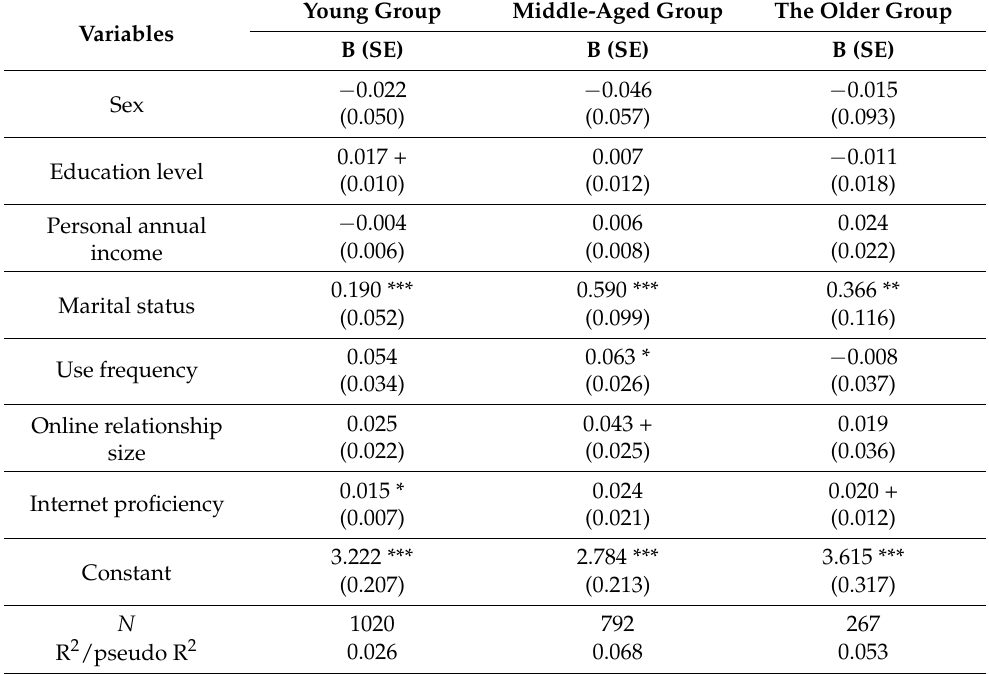
Table 4. Regression results of age heterogeneity of Internet use associated with subjective well-being (N =